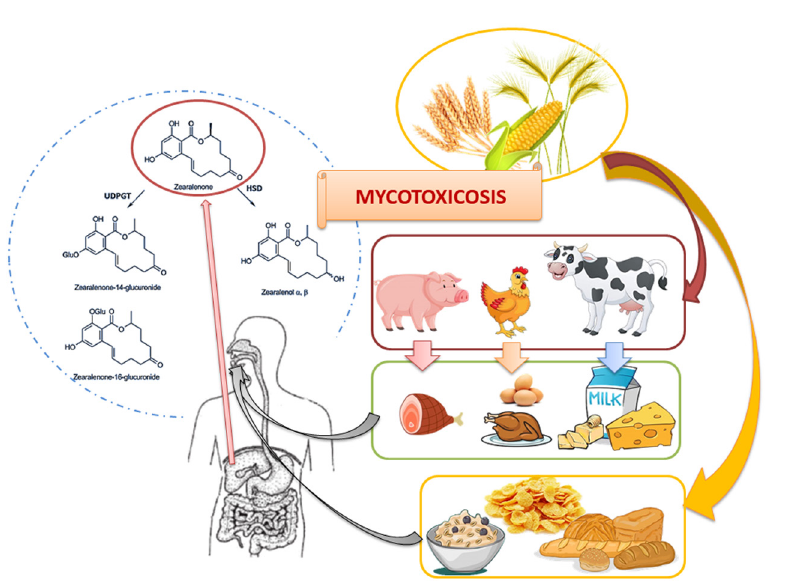
Figure 2: The infection pathway and zearalenone